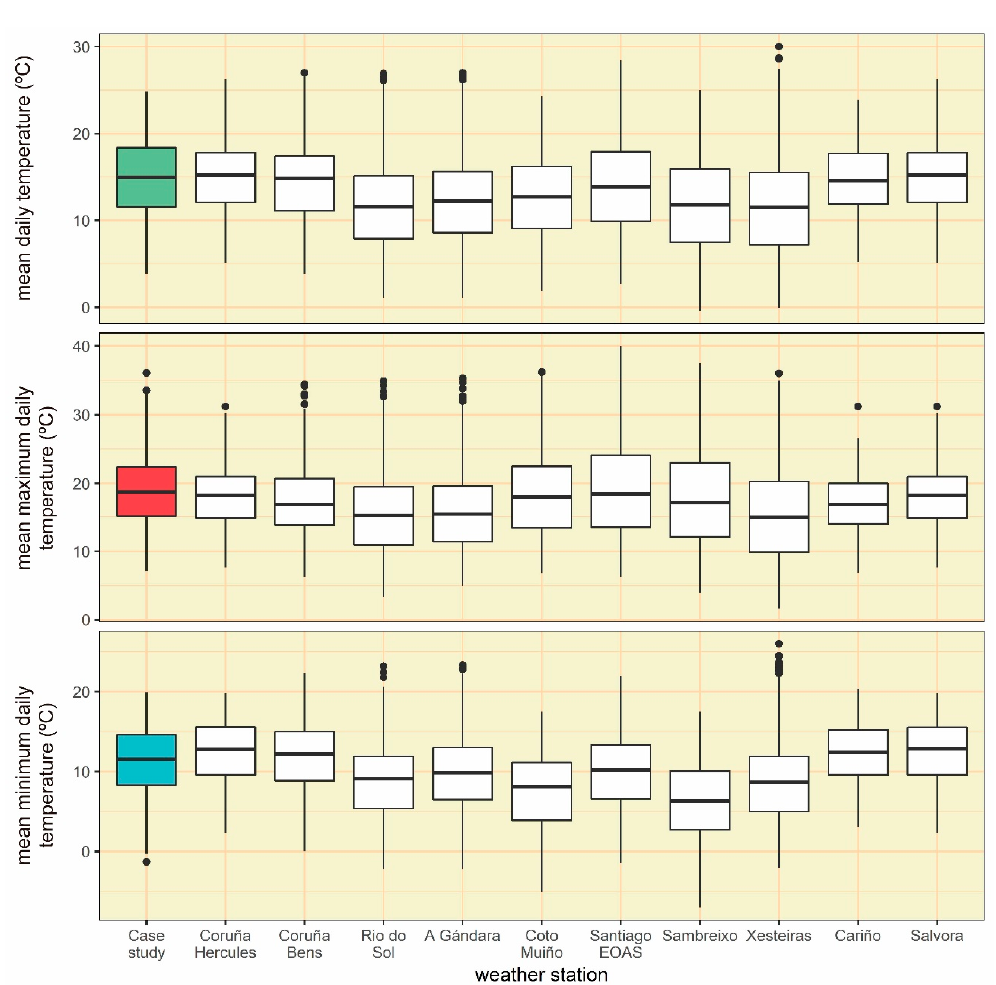
Figure 3. Box-plots of the daily temperatures of the case study and the weather stations. The upper and bottom lines represent 25% of the data distribution of maximum and minimum values, respectively. The points are outliers in the data distribution. Table 3. Coordinates of the weather stations.